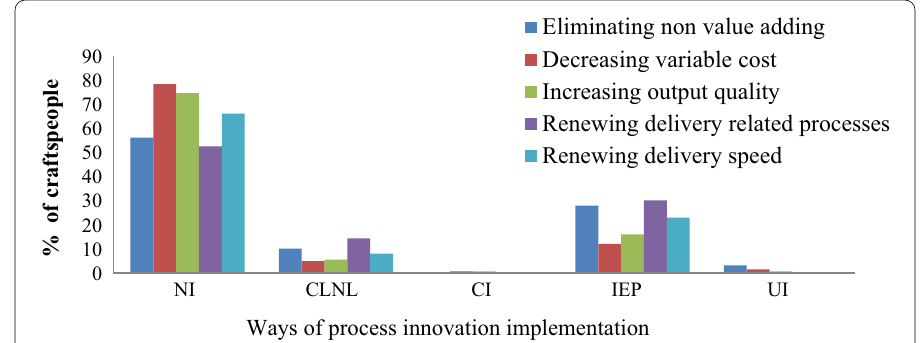
Fig. 5 Craftspeople process innovation implementation. NI Not implemented, CLNL copied from local and national level, CI copied from international level, IEP improved from own experience and product, UI unique breakthrough